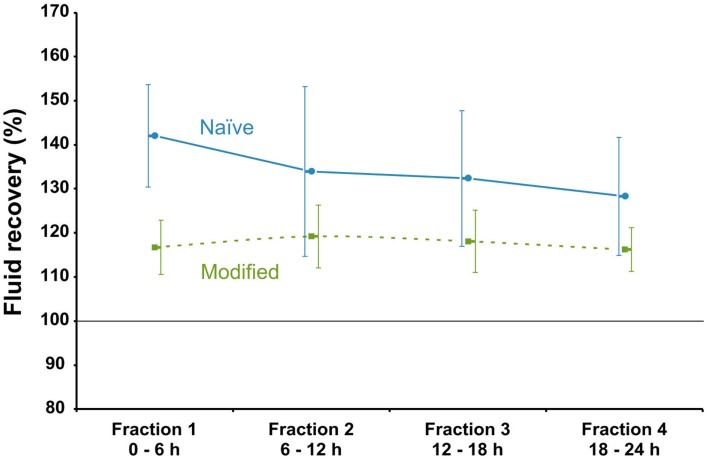
Fluid recovery as a function of time for naïve and the modified MD catheters in vitro. Fluid recovery as a function of fraction order in in vitro microdialysis in human ventricular CSF. Perfusion fluid CNS with 3% w/v Dextran 60 was delivered at 0.3 μL/min at 37°C. Blue solid line symbolizes naïve MD catheters and green dotted line surface-modified (Pluronic F-127) MD catheters (100 kDa Brain Microdialysis Catheter, M Dialysis AB). Error bars are based on ±1 SD of four surface-modified and untreated catheters, respectively (11). Reprinted with permission from Dahlin et al. (11). Copyright American Chemical Society.